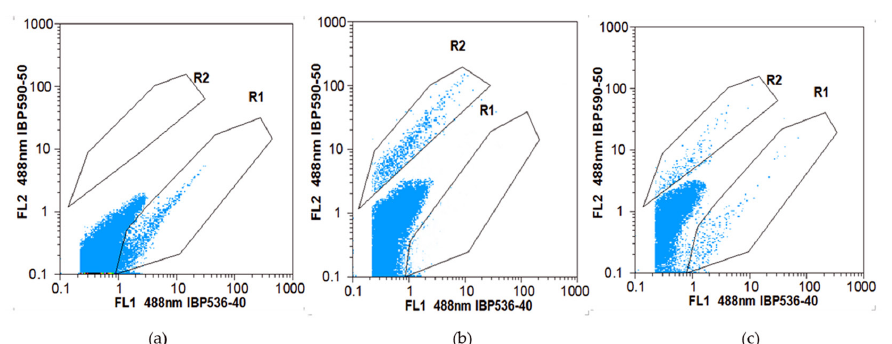
Fig. 5. Identification of live and dead cells of R. palustris with FDA-PI double-fluorescent staining. Dot plots representing carboxyfluorescein (R1) and propidium iodide fluorescent (R2) signals of R. palustris . Freshly harvested cells stained with FDA (a) and heat-killed cells were stained with PI(b). Multiparameter dot plot obtained after FDA-PI double staining of freshly harvested cells and heat-killed cells